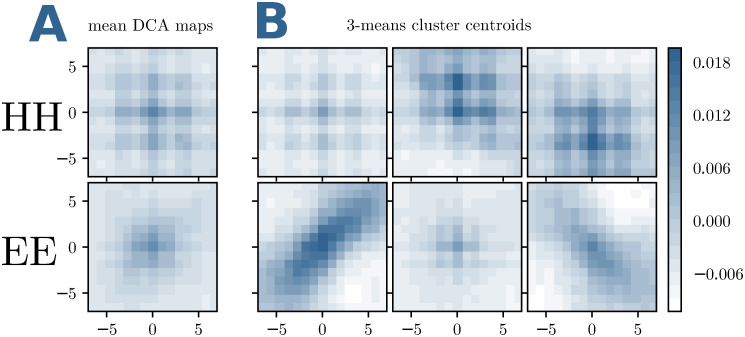
Typical patterns in DCA-score matrices.(A,B) The average DCA scores in a 15 × 15 window around an HH or EE contact are displayed, using the same selection of contacts as in Fig 1 for panels A, and the same sub-clustering for panels B.